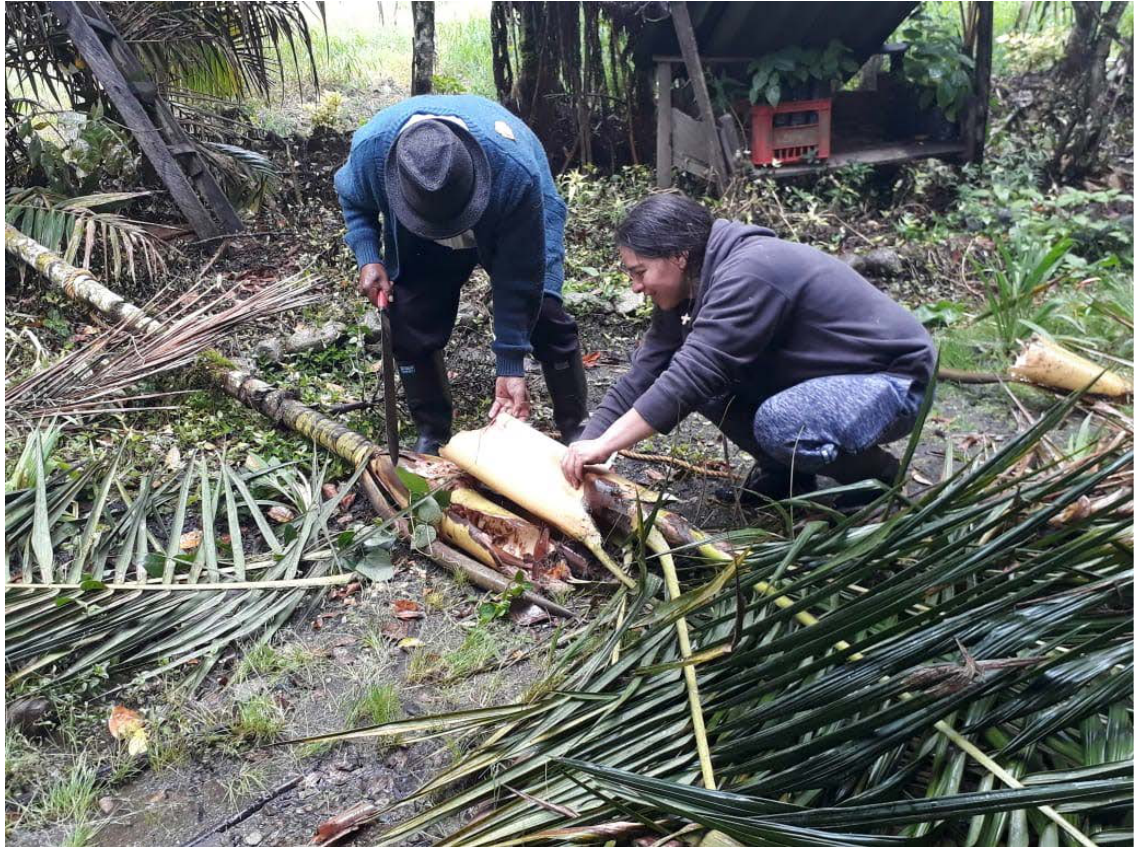
Figure 5. Grandfather and daughter collecting a palm for traditional dish preparation.